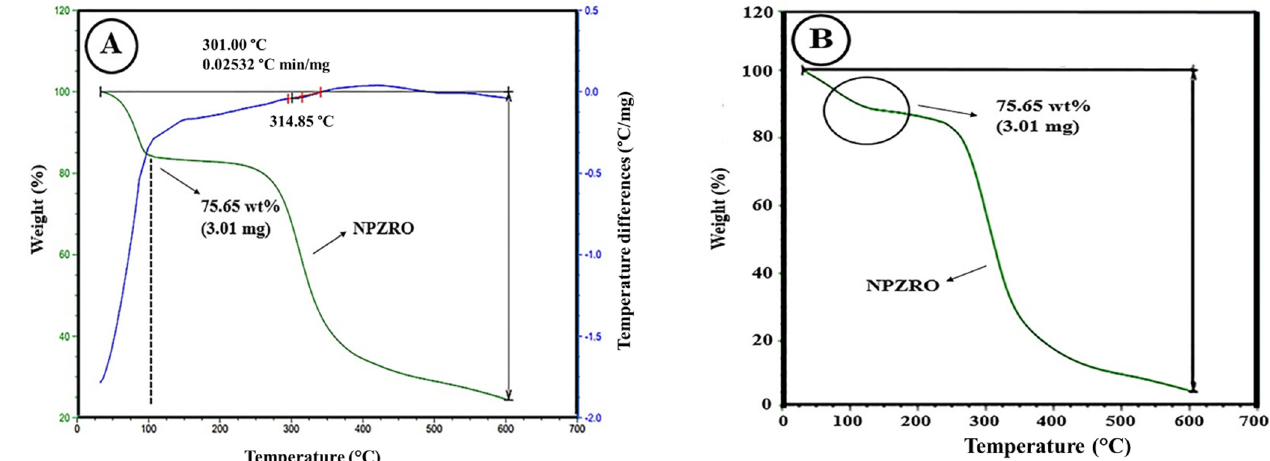
Figure 3. The curves of TGA ( A ) and ( B ) DSC of pure zein and NPZRO at a heating rate of 10 °C min − 1 under an N2 atmosphere.